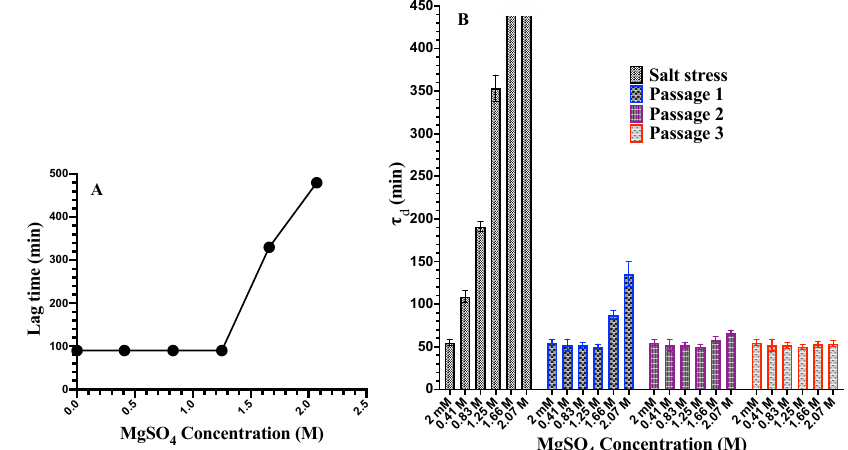
Figure 7. ( A ) Lag time as a function of magnesium sulfate concentration. The lag time increases with increasing concentration. ( B ) Population doubling time, τ d , during different passages after the removal of high salt stress. Open bars (1.66 M and 2.07 M) represent no growth. The population doubling time for the control cells grown at 2 mM MgSO 4 is 55 ± 5 min. The error on the τ d is estimated from the instrumentation error in the measurement of optical density as described in the